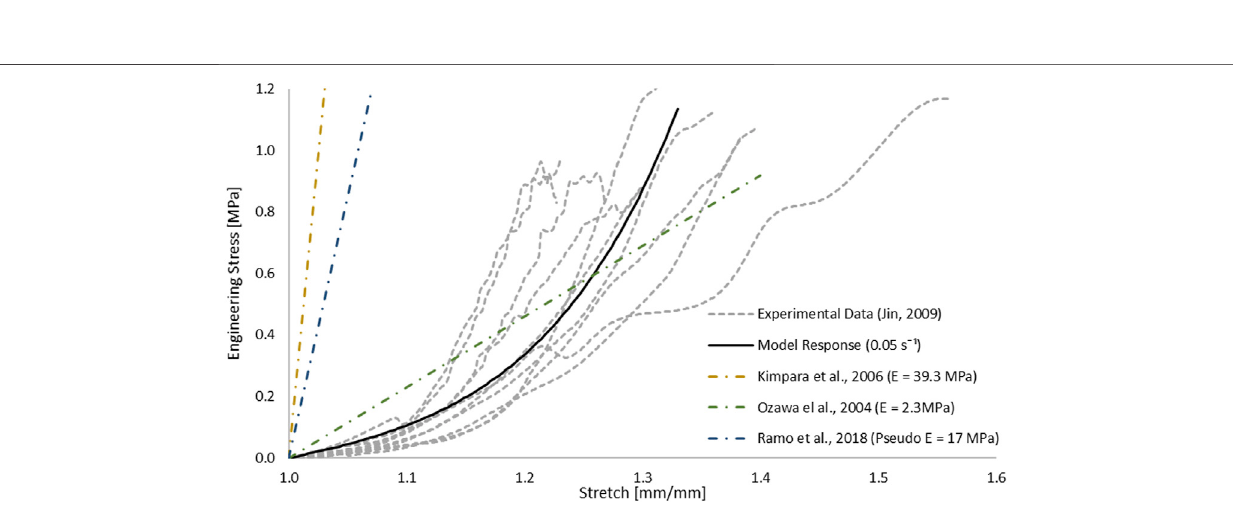
Frontiers in Bioengineering and Biotechnology |